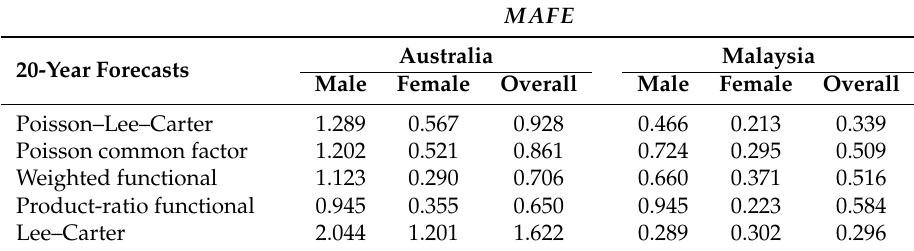
Table 4. Mean Absolute Forecast Error ( MAFE ) of life expectancy at birth by method, gender and country.